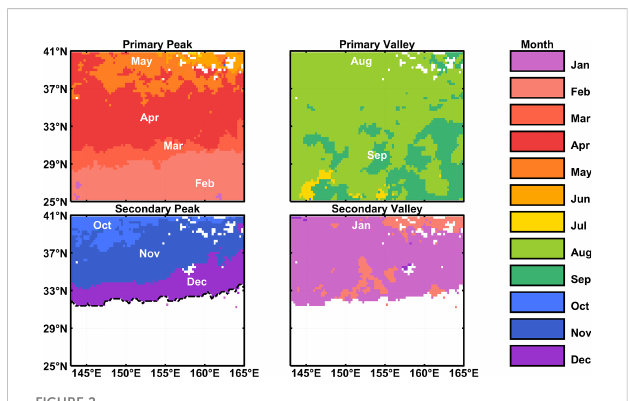
FIGURE 2 Peak and valley months of SCC seasonal cycle in the KE region.